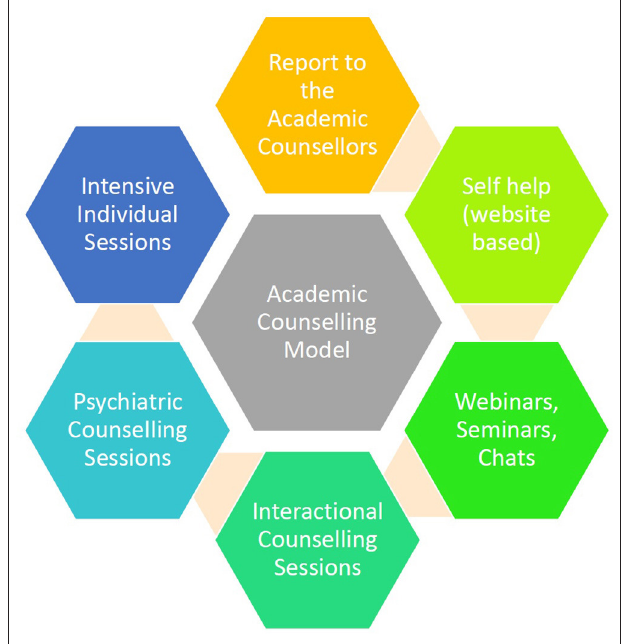
FIGURE 1 | Outlines the Counseling model to be used in the academic institutions if an individual gets afflicted with